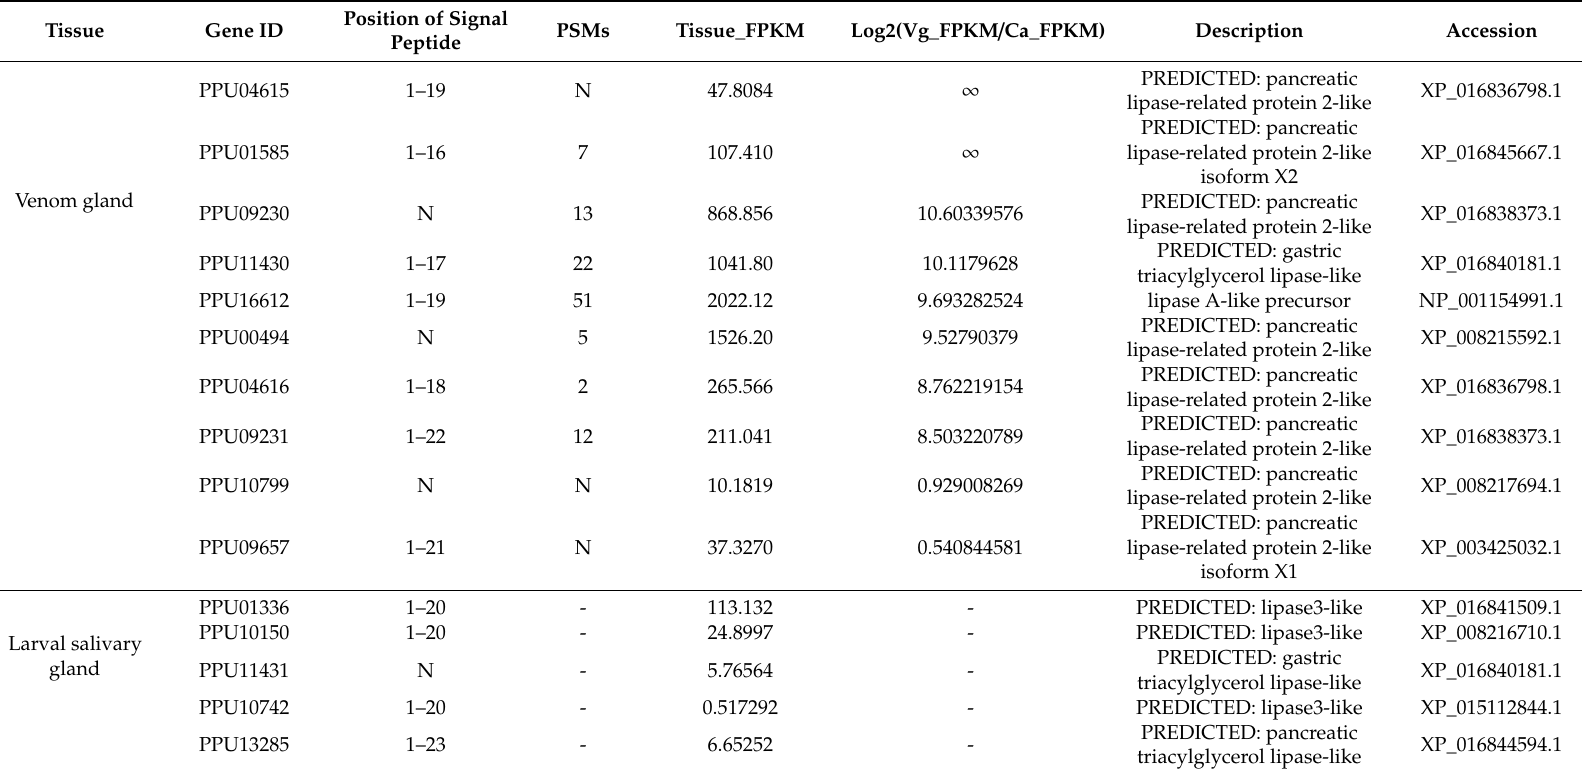
Table 2. Information of the lipases with especially high expression in venom glands and larval salivary glands of P. puparum .